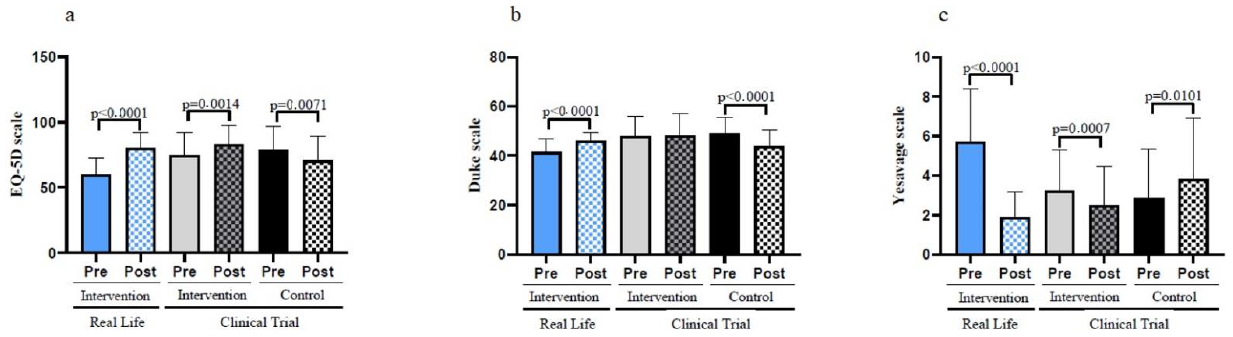
Figure 5. Self-rated emotional and social assessments before and after the interventions in old individuals. ( a ) Evaluation of the quality-of-life by using the EuroQol scale. ( b ) Results on the Duke Scale questionnaire for the social support perceived by the patient. ( c ) Results on the geriatric depression scale of Yesavage. Real-Life Intervention n = 50, Clinical Trial Intervention n = 51, Clinical Trial Control n = 49. Bars represent mean ± SD. Statistical analysis was performed with the Student’s t test for paired samples and the Wilcoxon test for non-parametric samples. The Duke scale is a questionnaire for the social support perceived by the